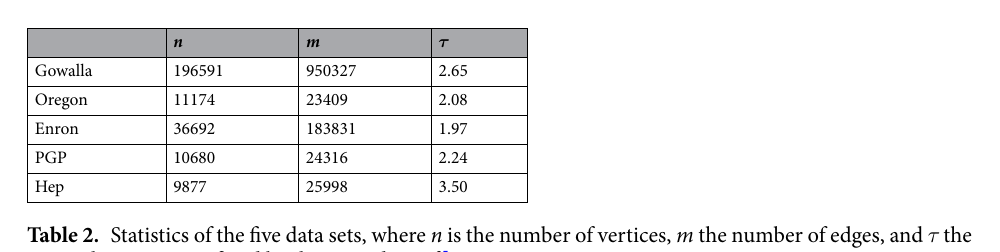
Table 2. Statistics of the five data sets, where n is the number of vertices, m the number of edges, and τ the power-law exponent fitted by the procedure of 5